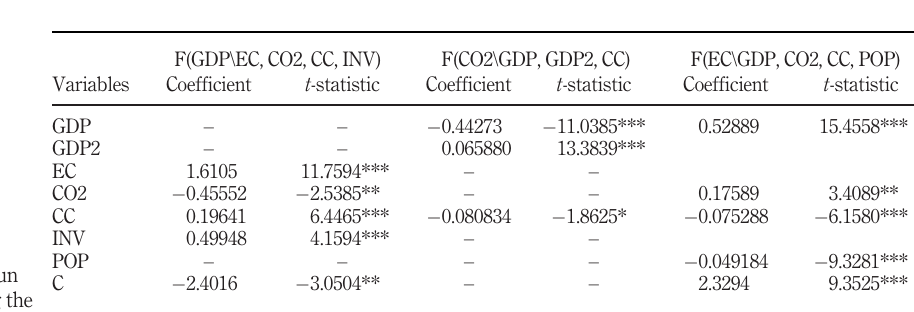
Table III. Estimated long-run coef fi cients using